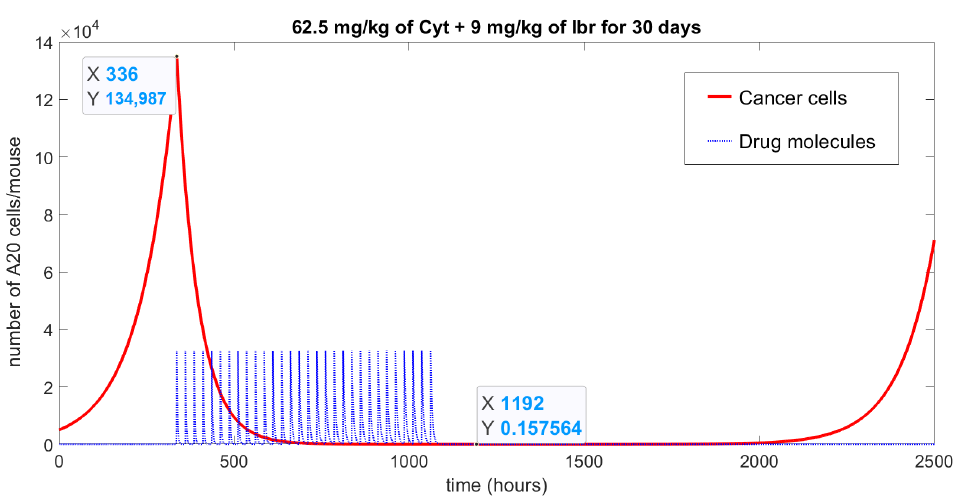
Figure A2. Numerical simulation of Equations (A1)–(A3) with parameters as in Table 1 and initial conditions: A ( 0 ) = 500; E ( 0 ) = 2500; C ( 0 ) = 0, represents the achievement of a tumor-free ( red solid line) state due to the action of a specific treatment protocol ( blue doted line): combined chemotherapy with 62.5 mg/kg of Cyt and 9 mg/kg of Ibr given for 30 days once a day. The treatment began after two weeks of cancer cells being “injected”; at that point, cancer growth reached 134,987 cells. Note that the chemotherapy curve has been divided by 10 11 to be able to show both curves in one